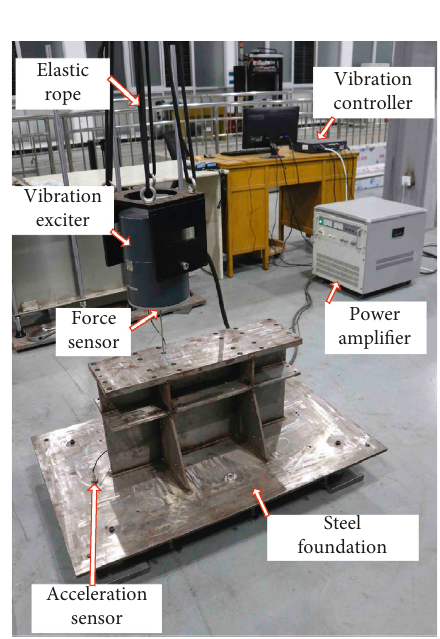
Figure 15: Test modal device.